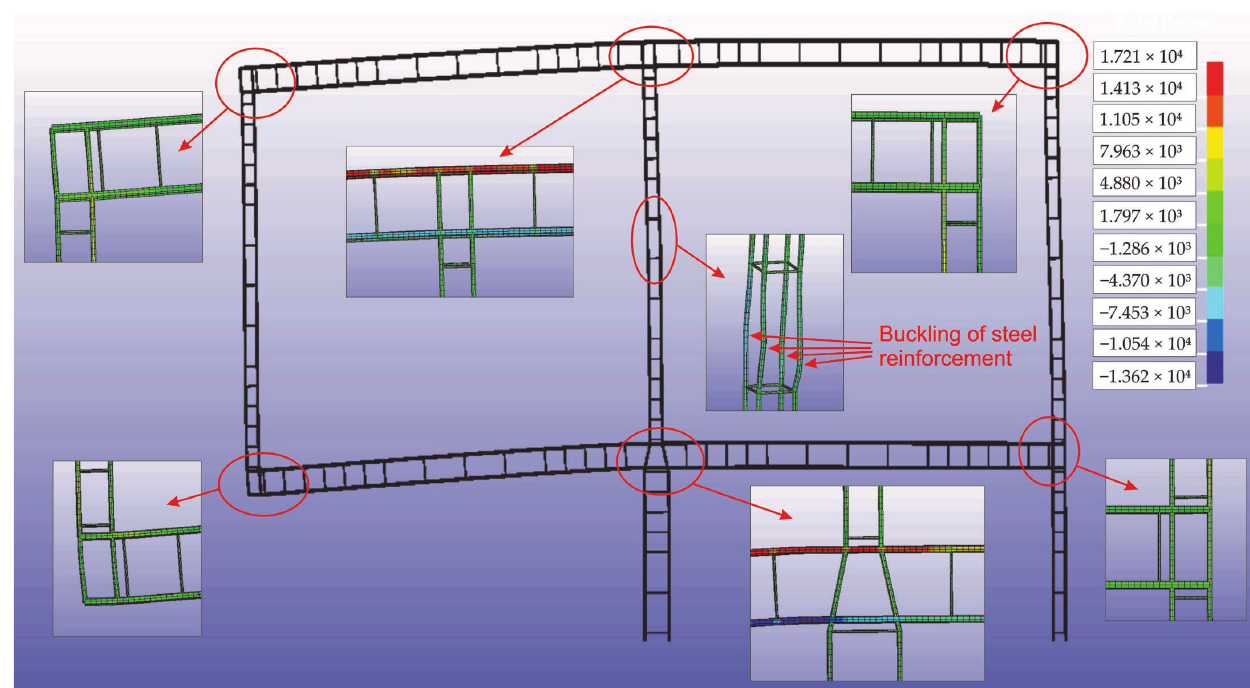
Figure 18. Axial forces in the steel reinforcement bars of the frame, N.